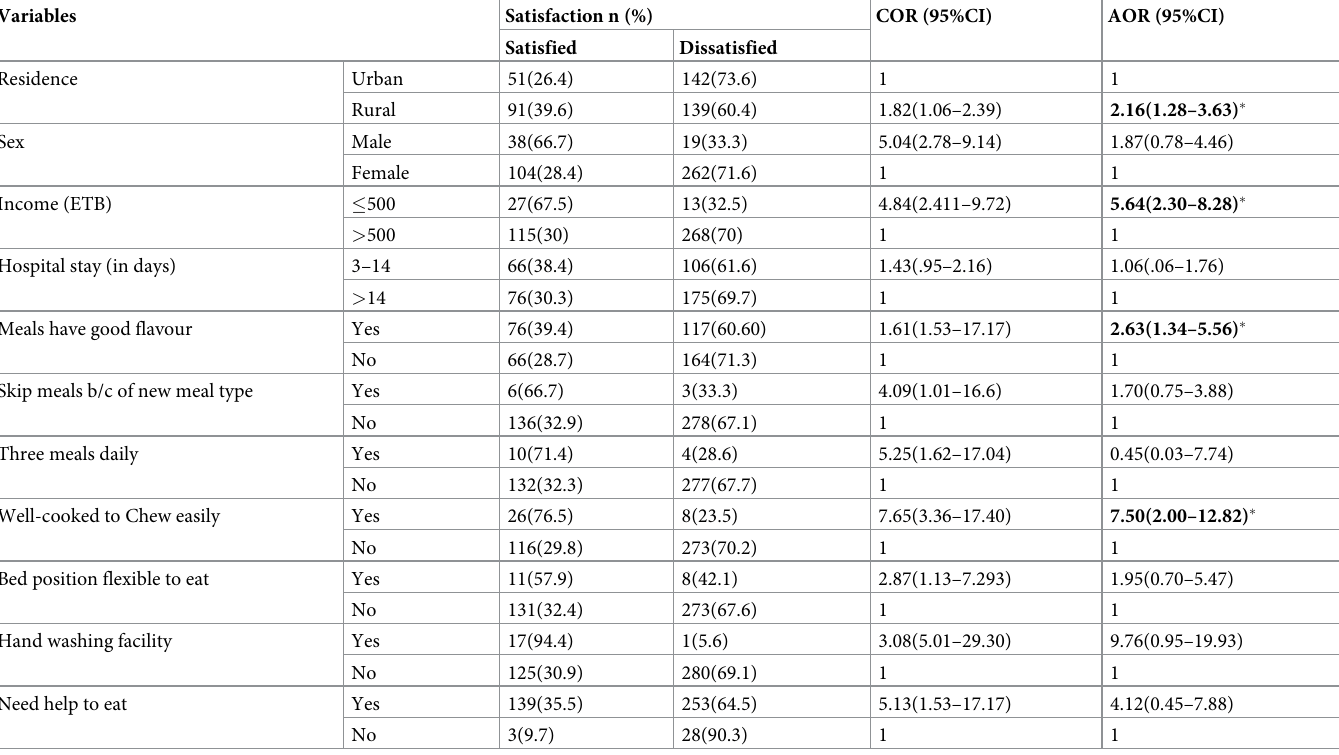
Table 3. Bivariate and multivariate logistic regression analysis of patient satisfaction with foodservice among adult patients,